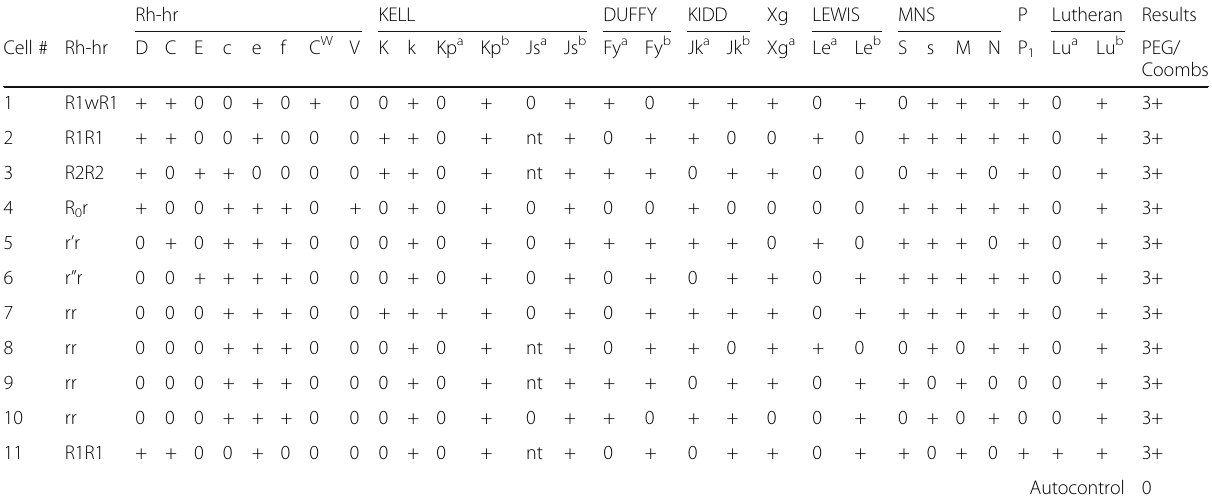
Table 1 Result of antibody screening Rh-hr KELL DUFFY KIDD Xg LEWIS MNS P Lutheran